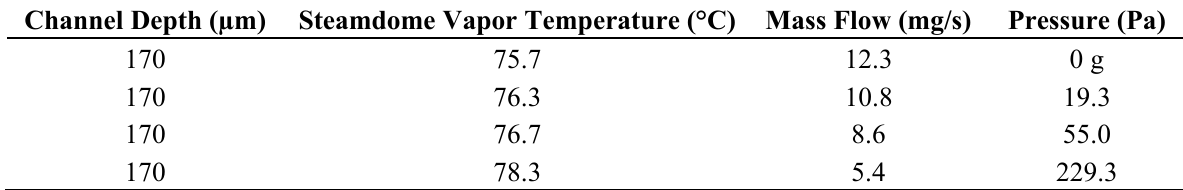
Table 3. Boiler operation at increased pressure and 3.6 W input.